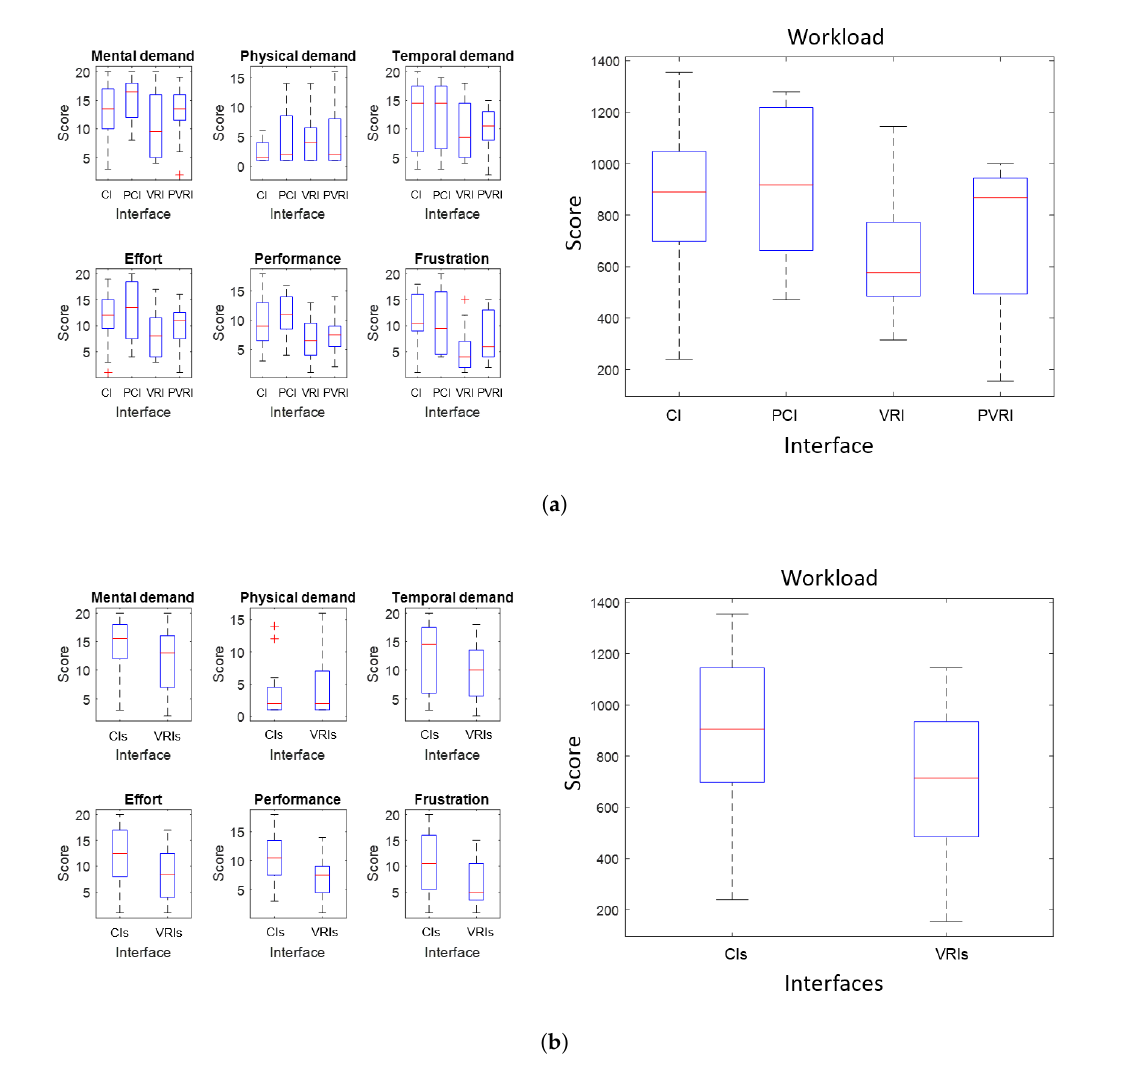
Figure 15. Box and whiskers diagrams for the workload and its variables. ( a ) Plot with the four interfaces: Conventional (CI), Predictive Conventional (PCI), Virtual Reality (VRI) and Predictive Virtual Reality (PVRI). ( b ) Plot with two groups of interfaces: Conventional (CIs) and Virtual Reality